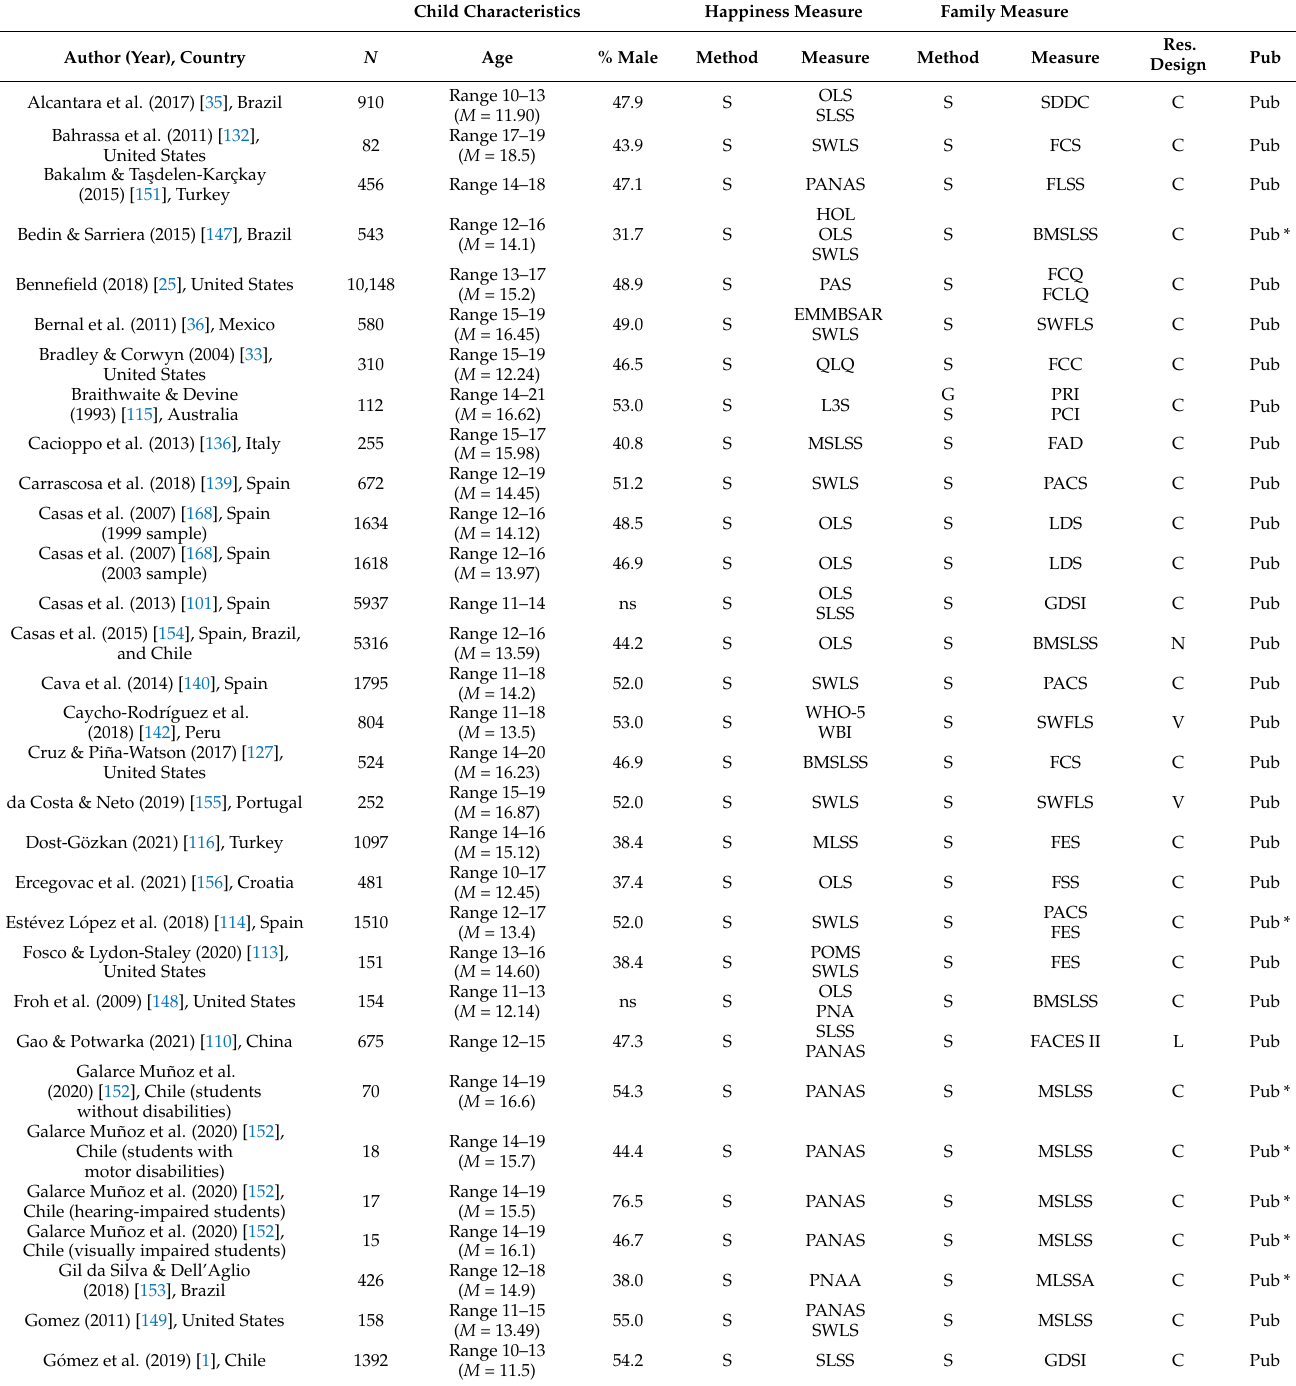
Table 1. Sample Characteristics and Methods of Assessment of the Reviewed Studies Investigating Family Dimensions and Happiness ( n =